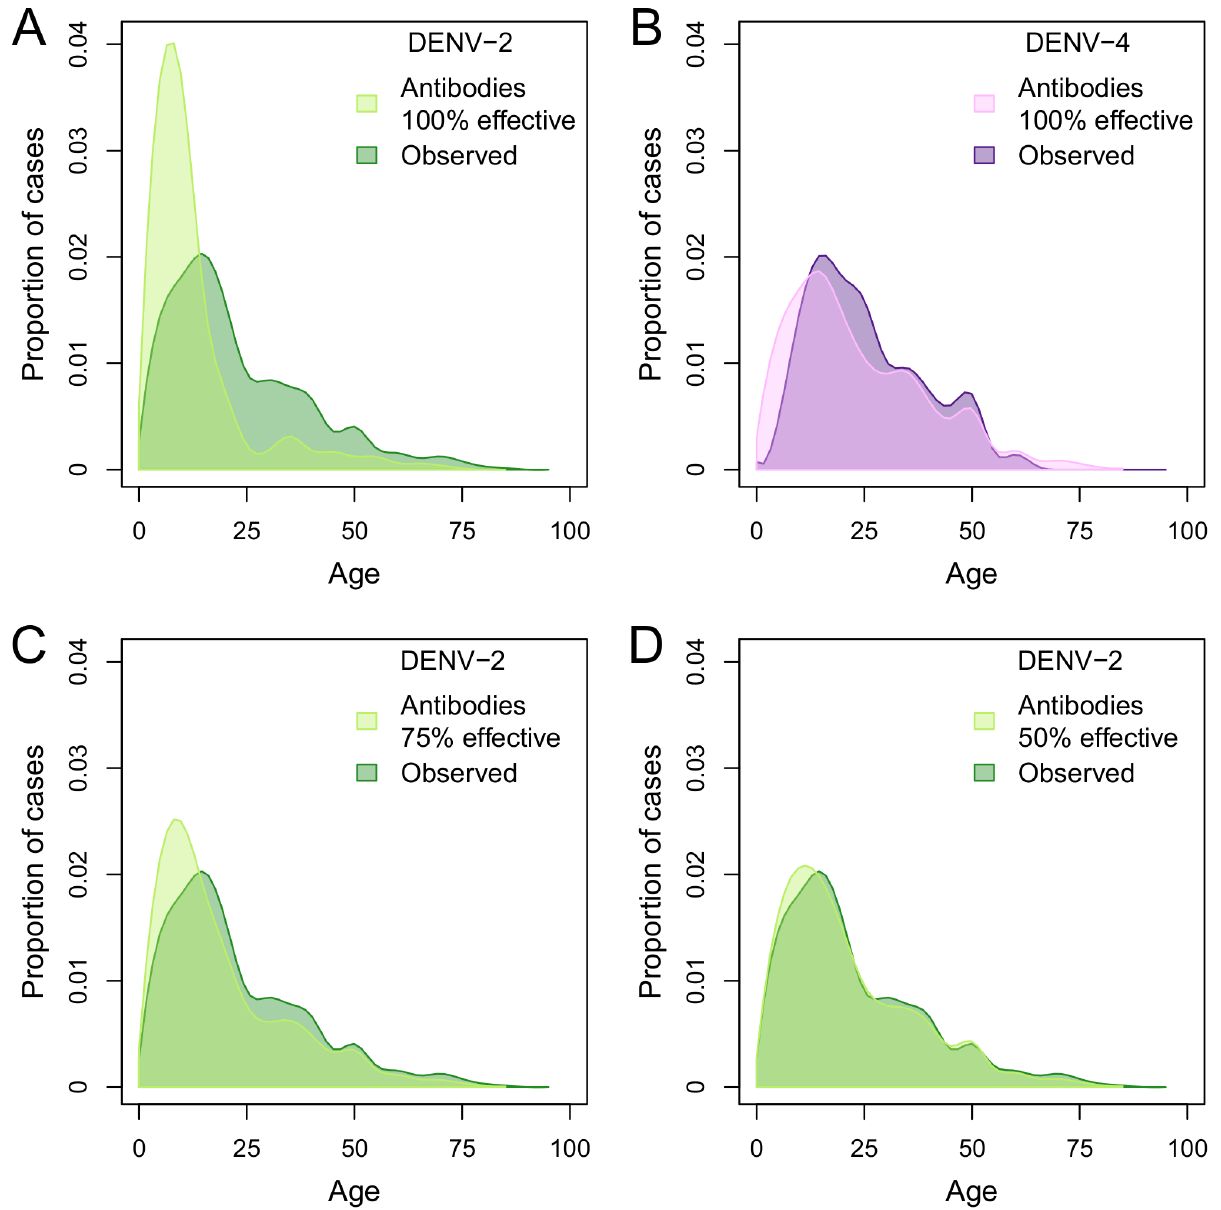
Fig 2. Expected versus observed DENV-2 and DENV-4 cases. The observed age distribution of cases of DENV-2 (dark green in panels A, C, and D) and DENV-4 (dark purple in panel B). Using the ages of all febrile individuals that participated in a clinic-based febrile surveillance study[17], we built an empirical estimate of the age distribution of individuals who sought treatment in Iquitos. By multiplying this distribution by the age-specific percent of the population with serotype-specific dengue antibodies, we created serotype-specific expected age distributions of cases for DENV-2 and DENV-4 (light green in panel A and light purple in panel B). We then adjusted the age- and serotype-specific immune levels and recalculated expected age distributions of cases for DENV-2 by assuming, across all ages, either 25% or 50% of those who should have been immune were still susceptible to DENV-2 (light green in panel C and light green in panel D,